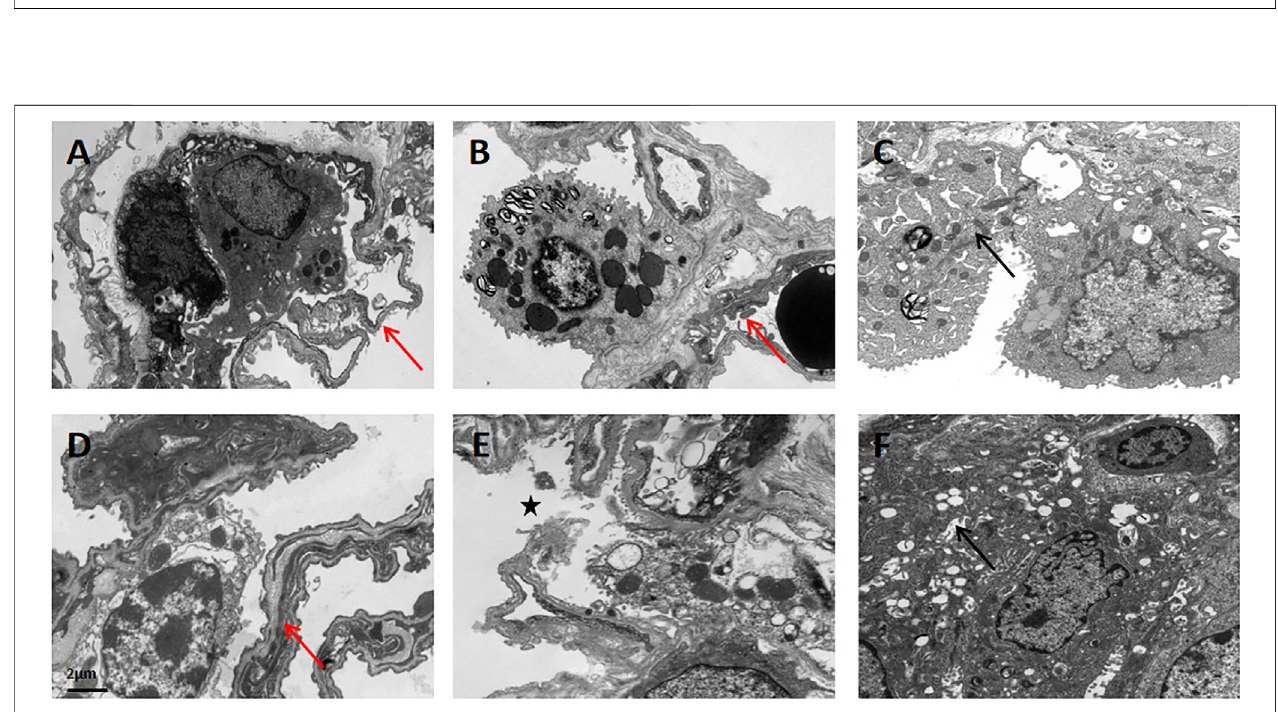
FIGURE 6 | Ultrastructural changes in lung tissue in the APRV and LTV groups by transmission electron microscopy. Lung tissues were obtained from the APRV group: (A) the upper lobe of the lung, (B) the middle lobe of the lung, and (C) the lower lobe of the lung and the LTV group: (D) the upper lobe of the lung, (E) the middle lobe of the lung, and (F) the lower lobe of the lung after whole lung saline lavage and 48 h of mechanical ventilation. Magni fi cation: ×8,000. Red arrow: tact alveolar – capillary barrier; star: destroyed alveolar – capillary barrier; black arrow: degenerated alveolar type II epithelial cells. APRV, airway pressure release ventilation; LTV, low tidal volume